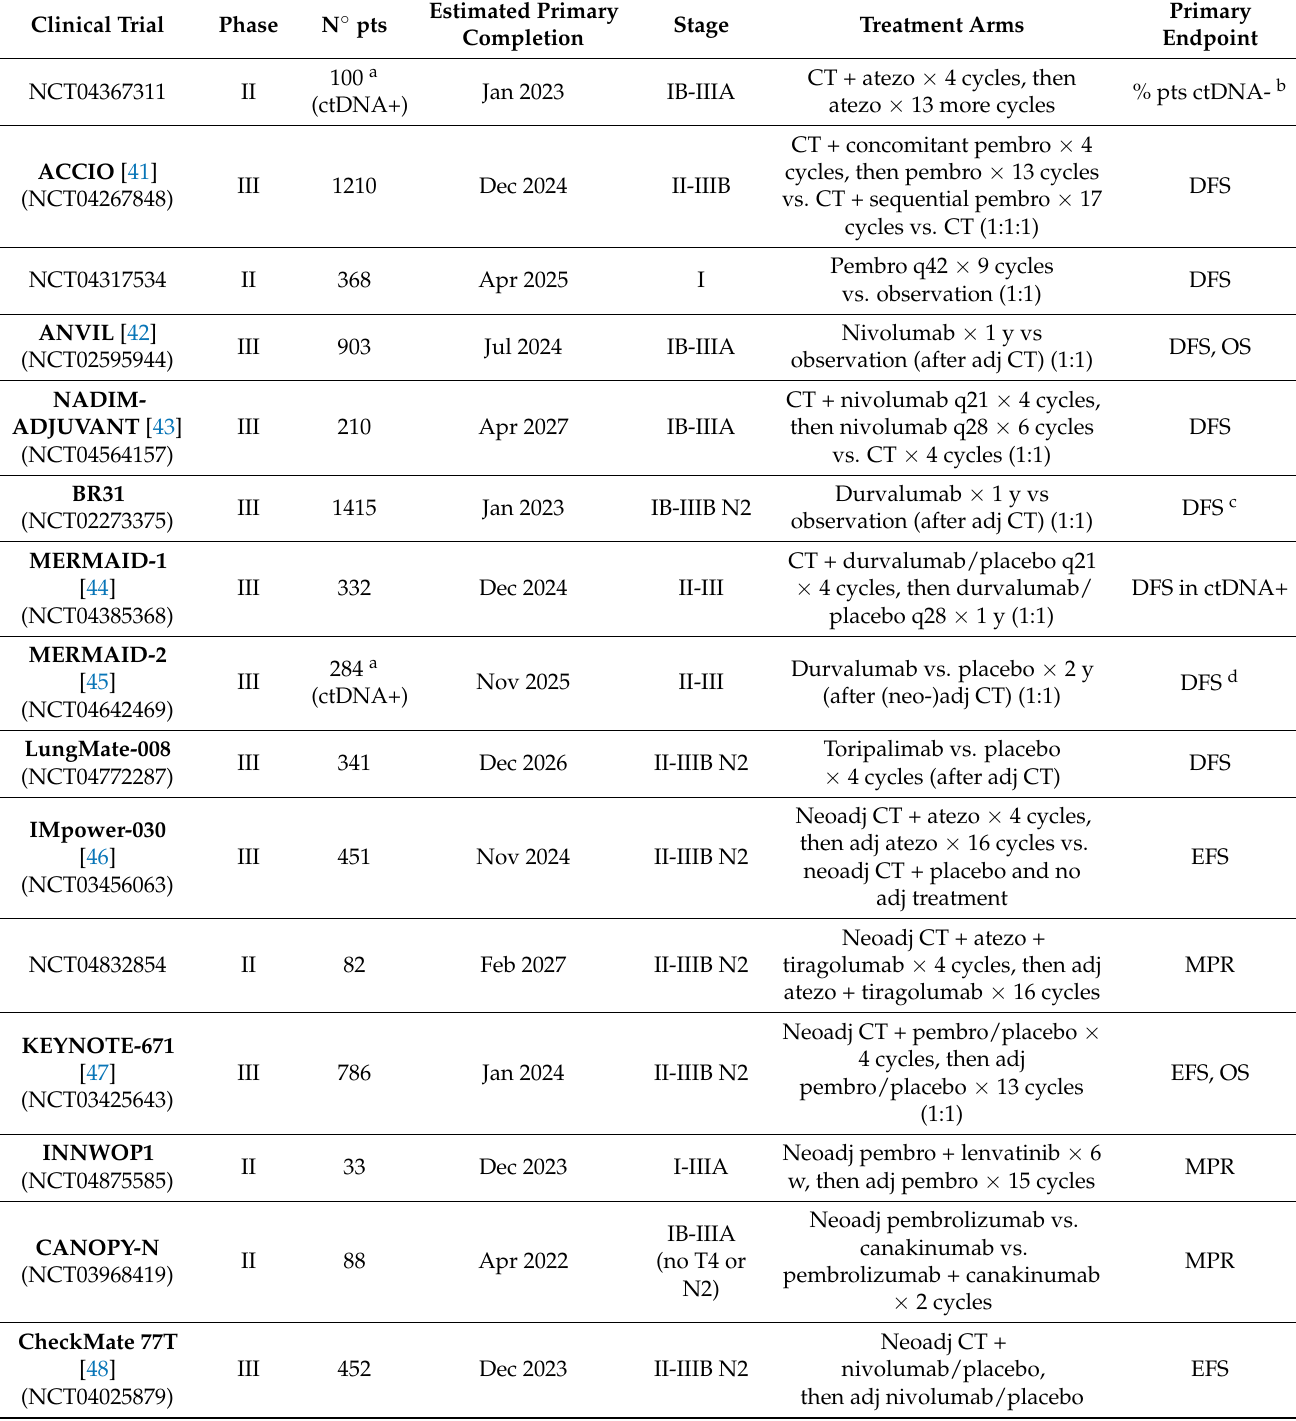
Table 6. Ongoing clinical trials with ICIs in the (neo-)adjuvant